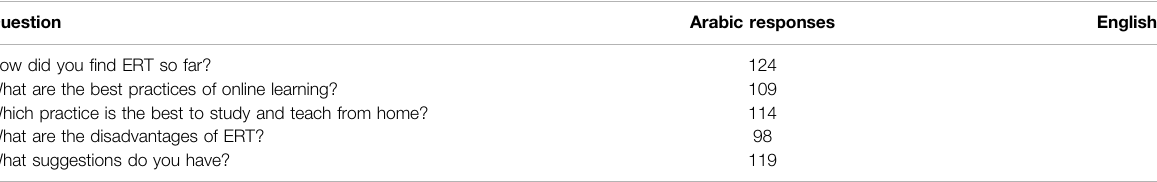
TABLE 2 | The questions and responses of the second re fl ective round on October 2020. Question